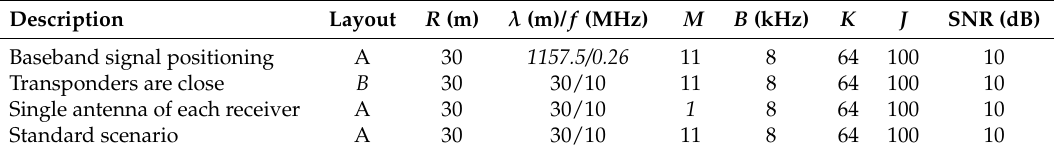
Table 1. Parameter setting in the numerical